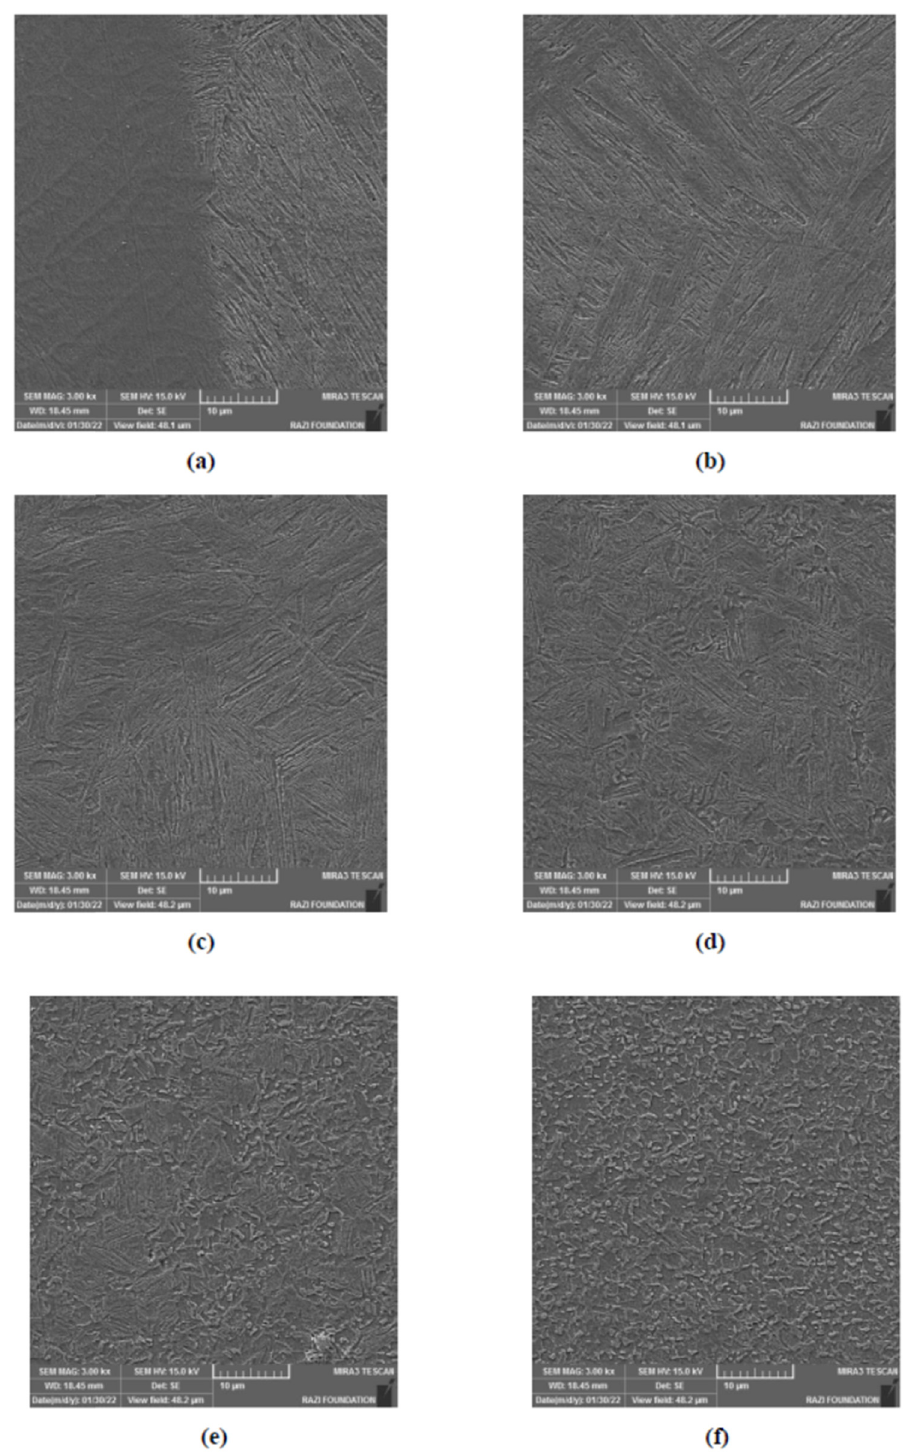
Figure 18: FESEM images from di ff erent regions of sample A: ( a ) nugget – HAZ interface; ( b – e ) from the HAZ toward the BM; ( f )